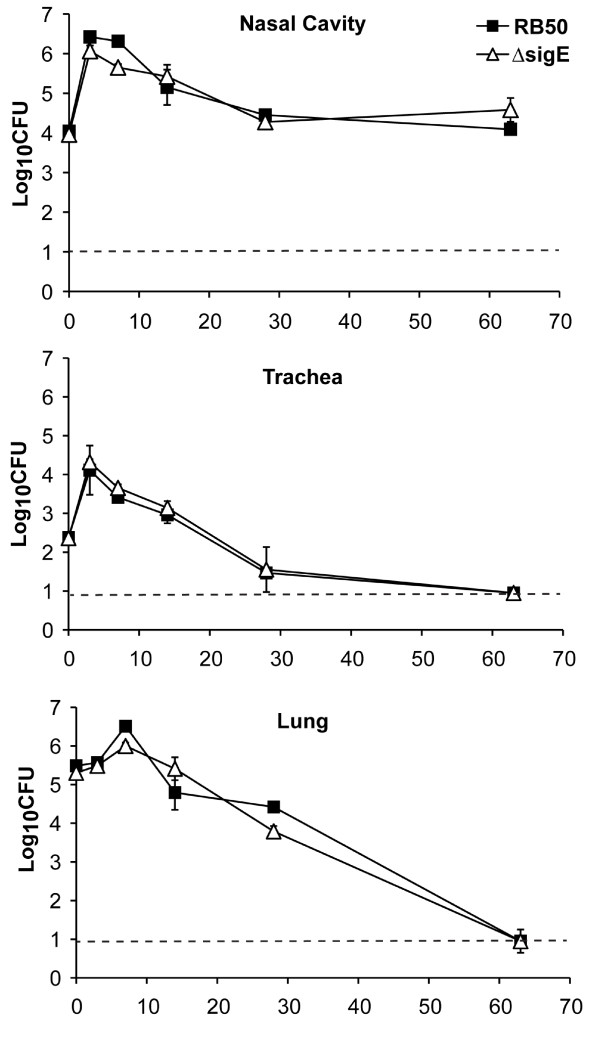
Colonization of the respiratory tract of C57BL/6 mice by RB50 and RB50ΔsigE. Groups of three 4–6 week-old C57BL/6 mice were inoculated with 5 × 105 CFU of RB50 (filled squares) and RB50ΔsigE (open triangles). Groups of three mice were sacrificed at each time point. The bacterial load in the indicated organ is expressed as log10 CFU ± SE. The dashed line indicates the limit of detection. The experiment was performed twice with similar results and a representative dataset is shown.